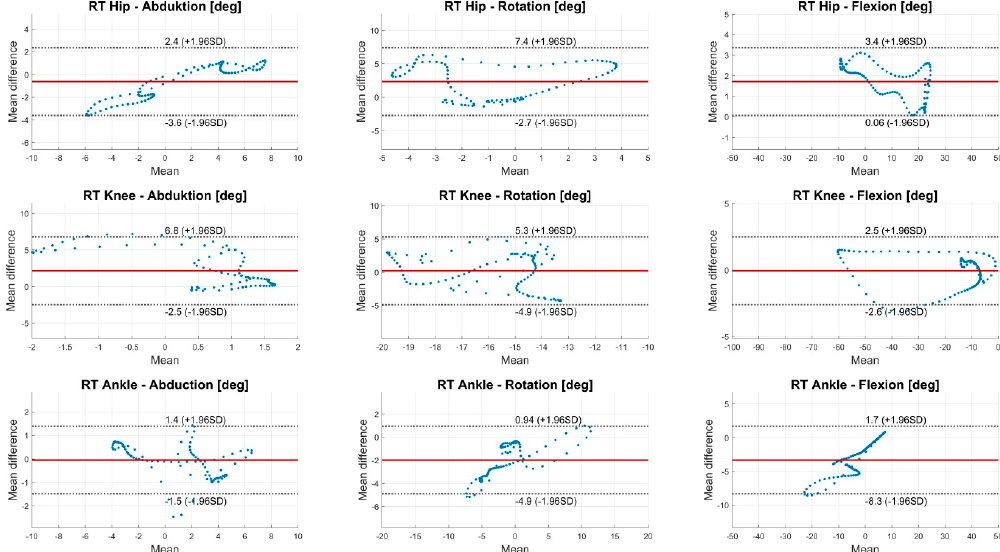
Figure A6. BA diagrams of 3D joint rotations of hip, knee, and ankle of the right side for condition 2. The solid line indicates the mean difference. The dashed lines indicate the LoA (95% CI) of the mean difference.